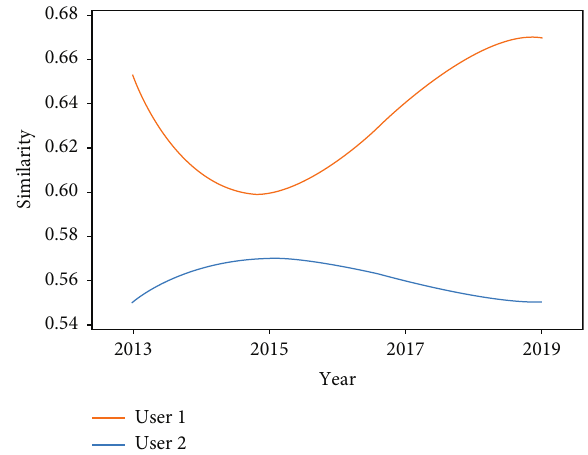
Figure 3: User changing similarity with an item throughout